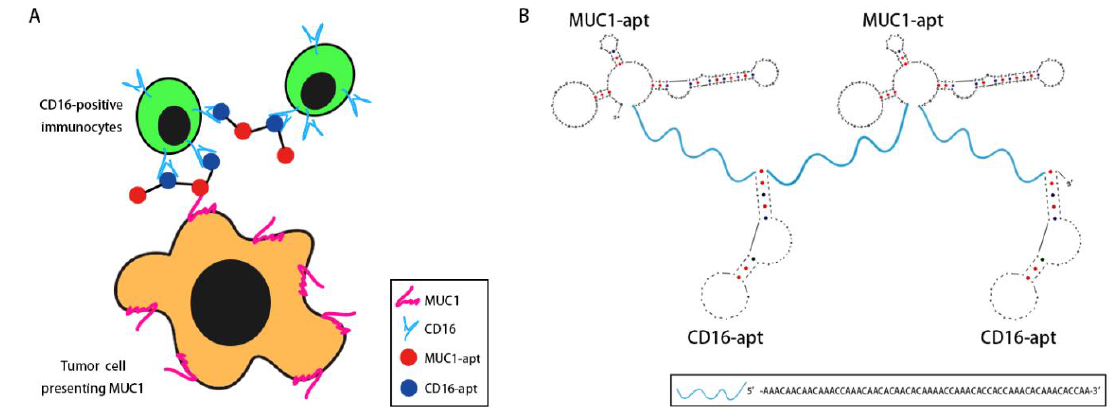
Figure 1. Design of bivalent bispecific aptamer (BBiApt): ( A ) Scheme of BBiApt recruiting CD16-positive immunocytes to MUC1-positive tumor cells. ( B ) The predicted secondary structure of BBiApt using UNAFold tools.